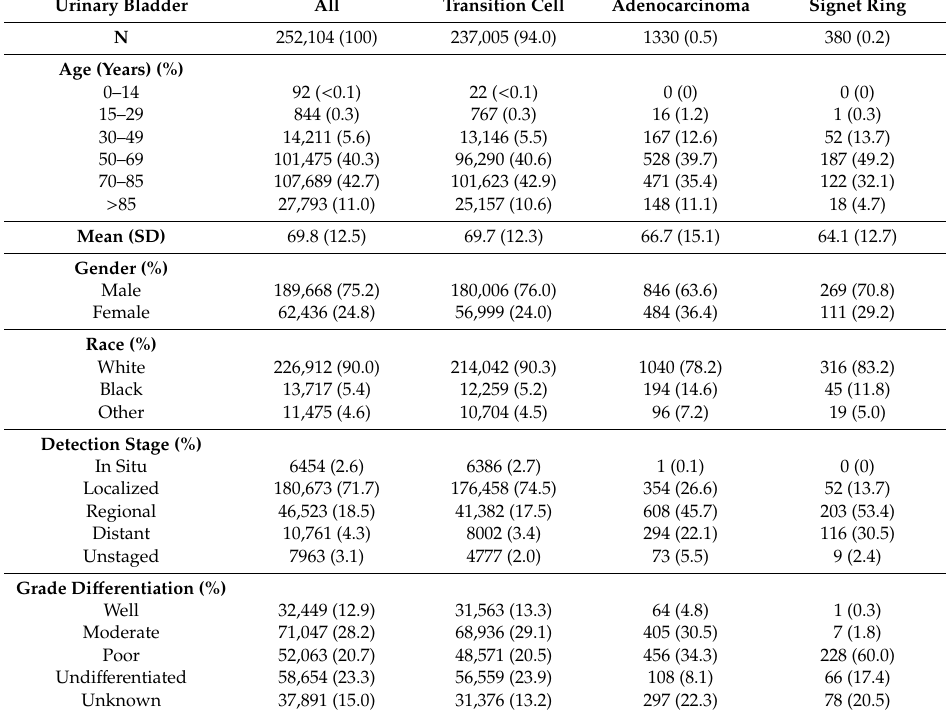
Table 19. Baseline demographics and clinical characteristics by histology for urinary bladder